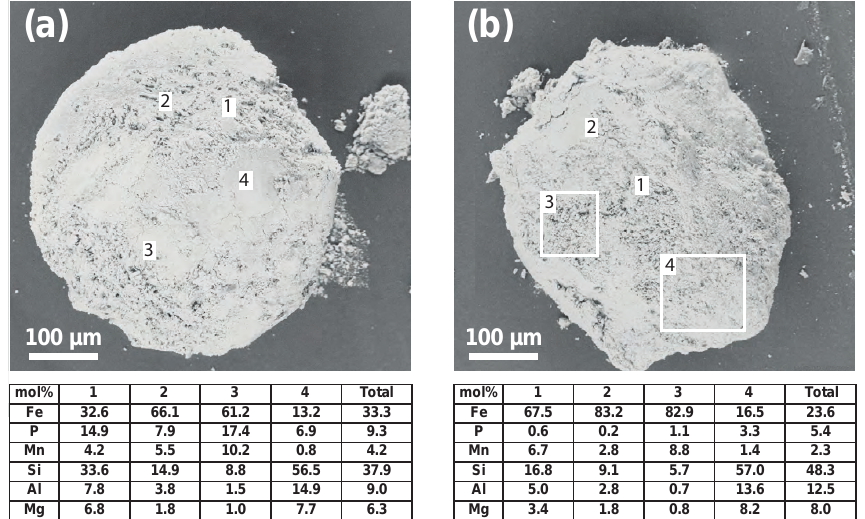
Figure 8. SEM-EDS images of blue aggregates from 11.98mcd (hole A HR ) with elemental concentrations in mol%. The EDS results include analysis of spots and specific areas (1–5), and total area analysis.